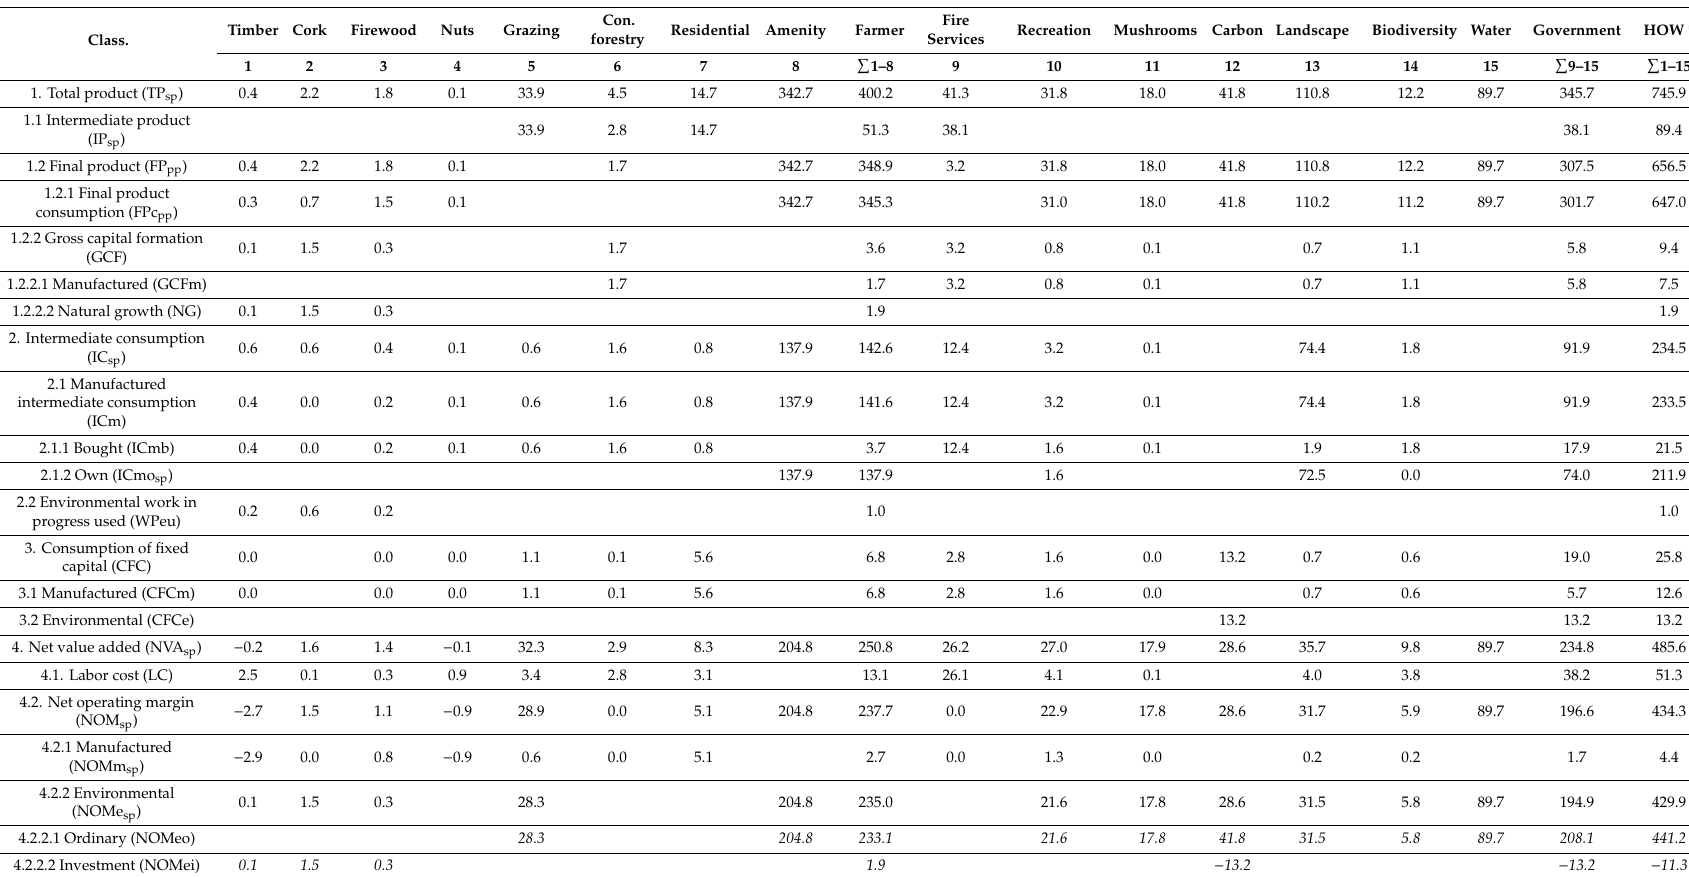
Table 1. Agroforestry Accounting System total production account at social prices applied to holm oak open woodlands in Andalusia (2010: € / ha)